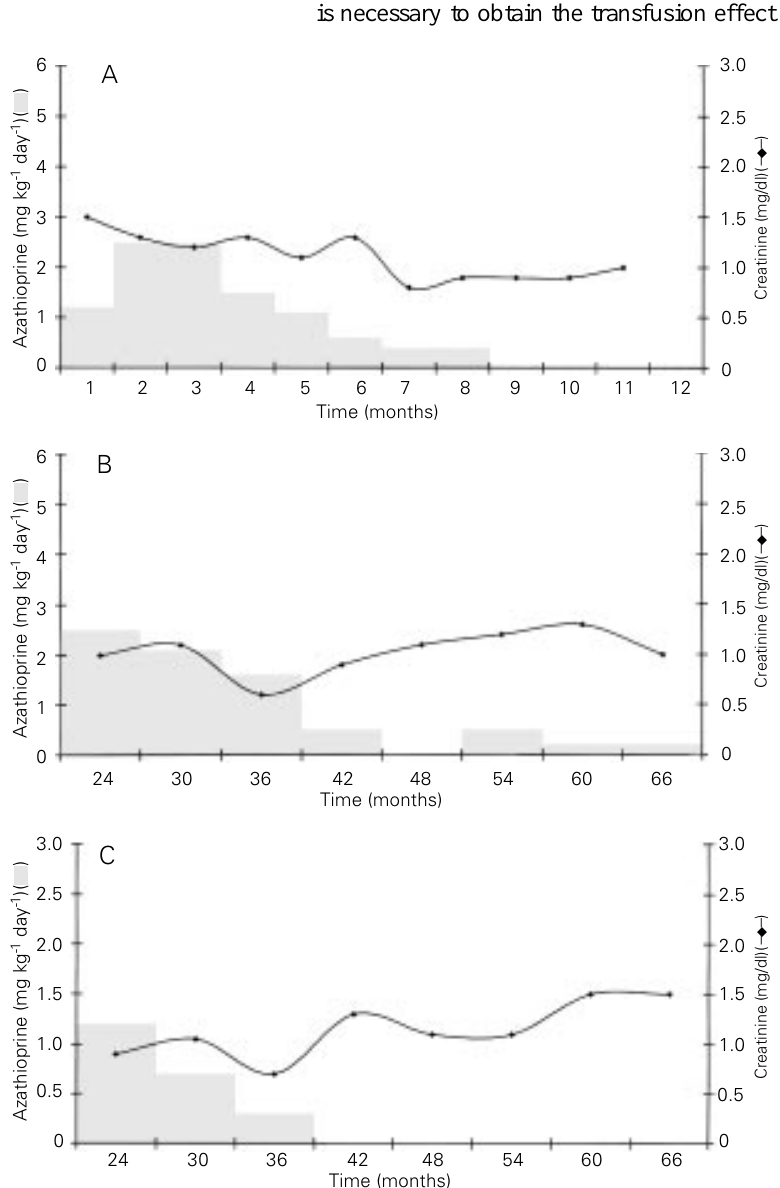
Figure 2 - Transfused patients maintained on monotherapy with prednisone for 3 (A), 6 (B) and 30 (C)